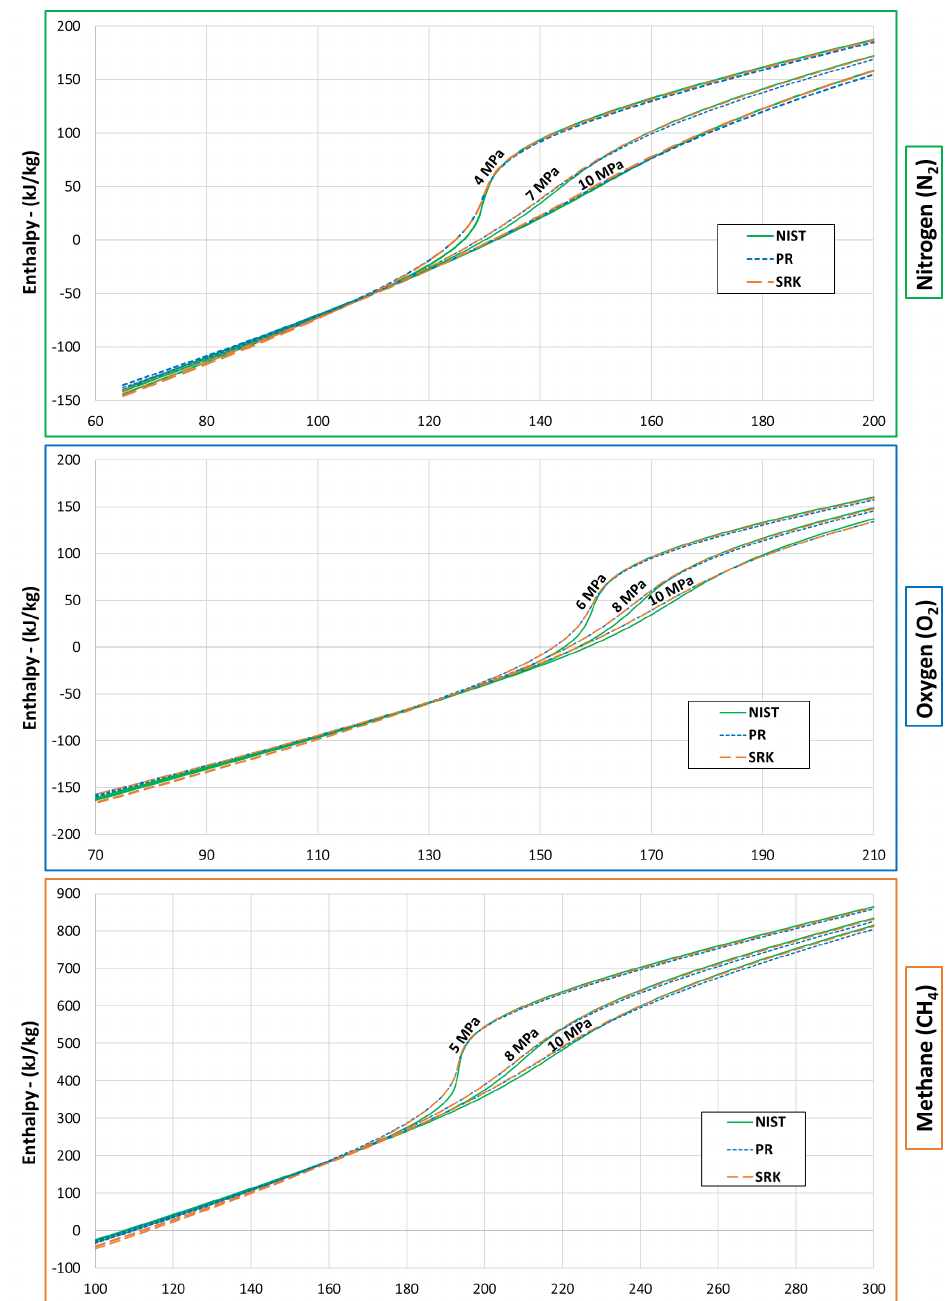
Figure 3. Plots of estimated enthalpy using density from PR and SRK compared against NIST for cryogenic fluids (N 2 , O 2 and CH 4 ) at three supercritical